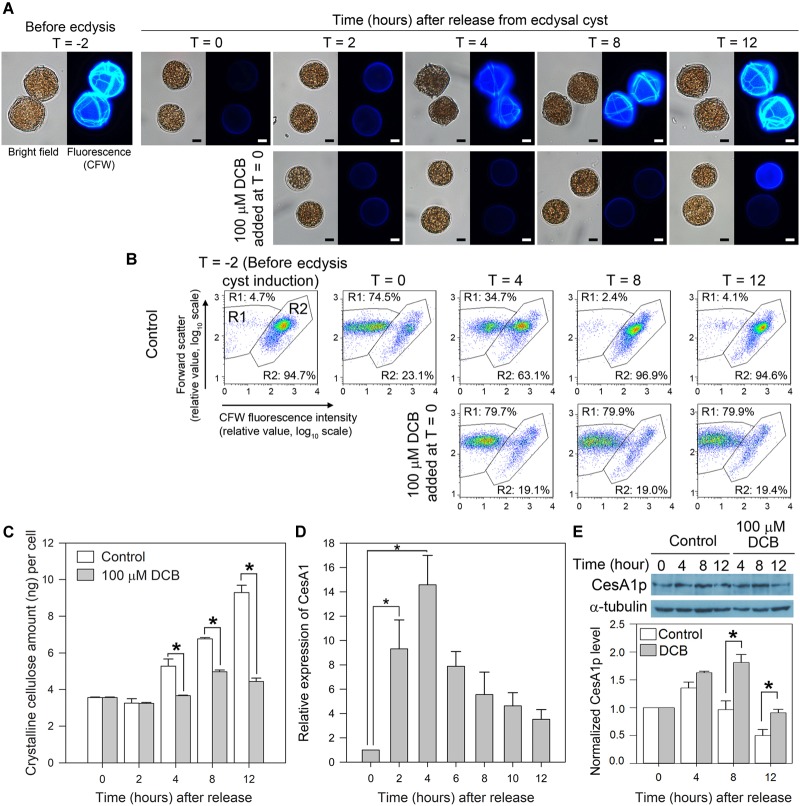
LpCesA1 expression and cellulose synthesis (CS) during cyst-to-swarmer transition. (A) Fluorescence photomicrographs of L. polyedrum cells (stained with CFW) during cyst-to-swarmer transition (TC–S). Control contained 0.0625% (v/v) of DMSO, the vehicle for DCB. Ecdysis resulted in a decrease in cellulose content (CFW fluorescence) from T = –2 to T = 0. (B) CFW (cellulose)-stained cells were distributed in R1 and R2 regions in relation to their relative CFW fluorescence intensity and cell size (forward scatter). R1, with less CFW staining should be the ecdysal cyst whereas the R2 should be the swarmer cells (and cyst with attached cell wall). However, these two populations were complicated with some shed cell-wall attaching to the ecdysal cyst. DCB served as a negative control for cells which did not increase in cellulose content, verifying sub-population of R2 cells had detached cell wall (some R2 cells had larger FSc). Almost all cells had higher level of CFW-staining by T = 8–12, suggesting continuous cell wall growth after regaining motility (between T = 4 and T = 8 in different cells). The 74.5% (R1) was thus an underestimate for ecdysal cyst, as no swarmer cell could be identified in DCB-treated cells; transfection involved lipofectamine and additional centrifugation, nor did visual observation reveal any motile cells in T = 0 sample. (C) Crystalline cellulose levels per cell during TC–S. (D) Levels of LpCesA1 transcripts during TC–S. (E) Anti-CesA1p immunoblot of cell lysates collected during TC–S. Control experiment: DCB (100 μM) completely inhibited the reformation of CTPs (A) and significantly (P < 0.05) decreased cellular cellulose content (C) throughout the experiment. The residual cellulose likely corresponded to attached old cell wall which were not removed from vegetative cells after washings. Scale bars represent 10 μm. Relative expression pattern reports normalized signals of CesA1p with alpha-tubulin signals. Data represent means ± SE of triplicate experiments. Asterisks (∗) indicates significantly different from control (P < 0.05).